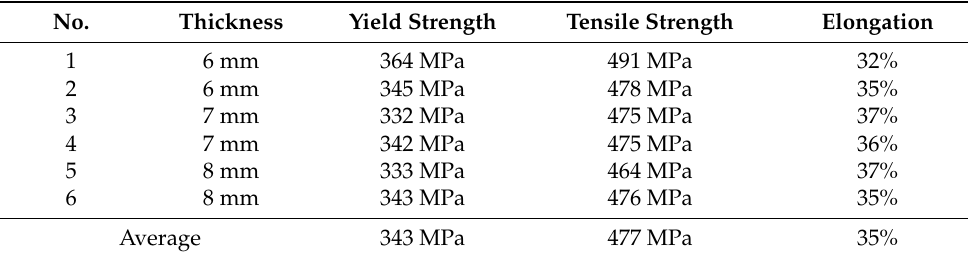
Table 3. Mechanical properties of the curved